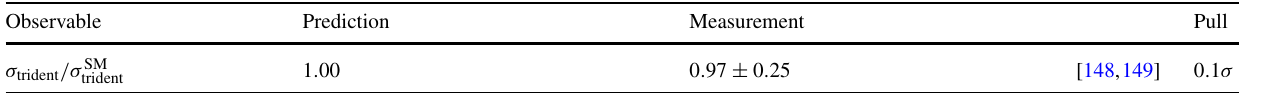
Table 4 Observable: neutrino trident production Observable